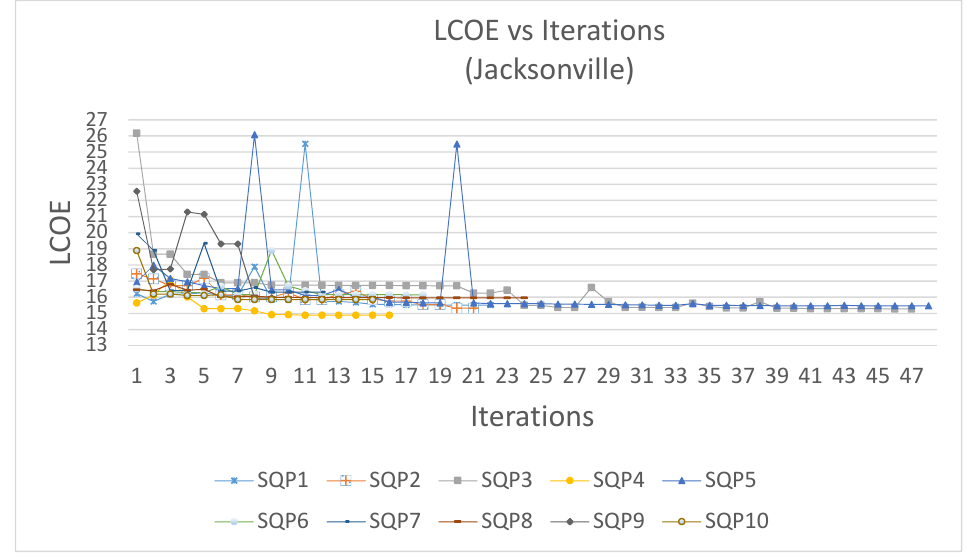
Figure 4. Optimization iteration summary for Jacksonville.